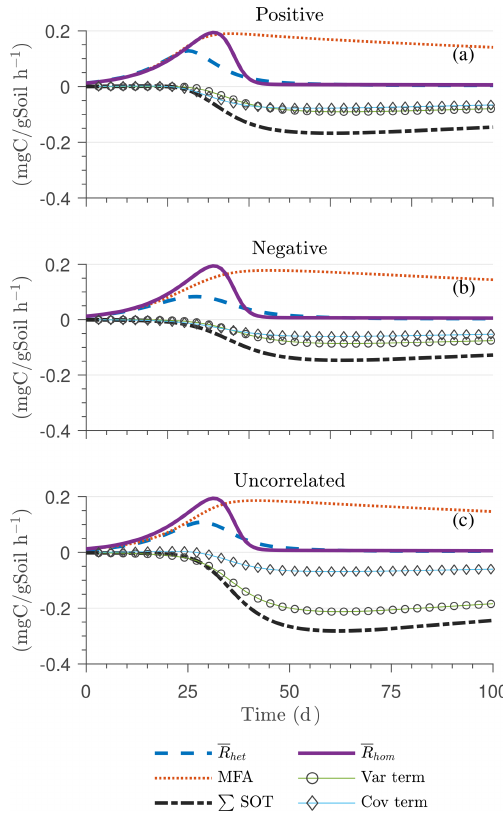
Figure A6. Scenario 2 (HS with inverse Michaelis–Menten kinet- ics): temporal evolution of mean respiration rate in the biophysi- cally heterogeneous system ( R het , including the mean field approx- imation (MFA) and second-order terms) and the respiration rate in the homogeneous system ( R hom ) for (a) positively and (b) nega- tively correlated or (c) uncorrelated substrate and microbial